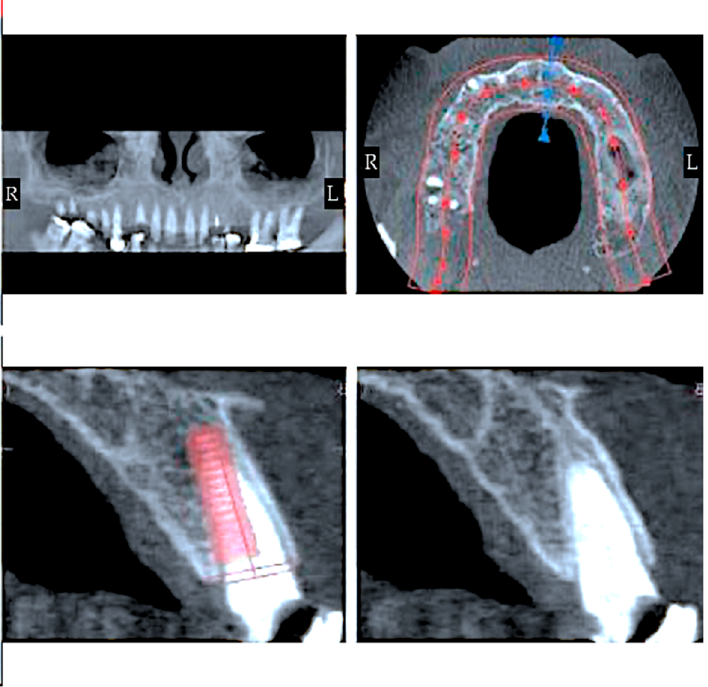
Figure 3. Cone beam-computed tomography planning in the maxilla [38].